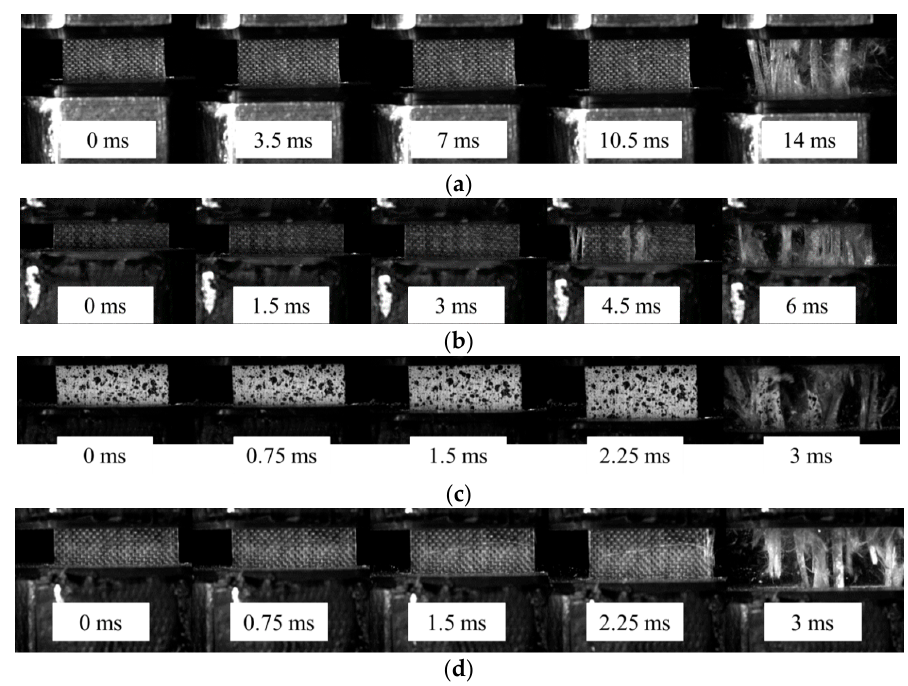
Figure 5. Failure behaviors of GFRP at different strain rates: ( a ) 25 s − 1 ; ( b ) 50 s − 1 ; ( c ) 100 s − 1 and ( d ) 200 s − 1 .